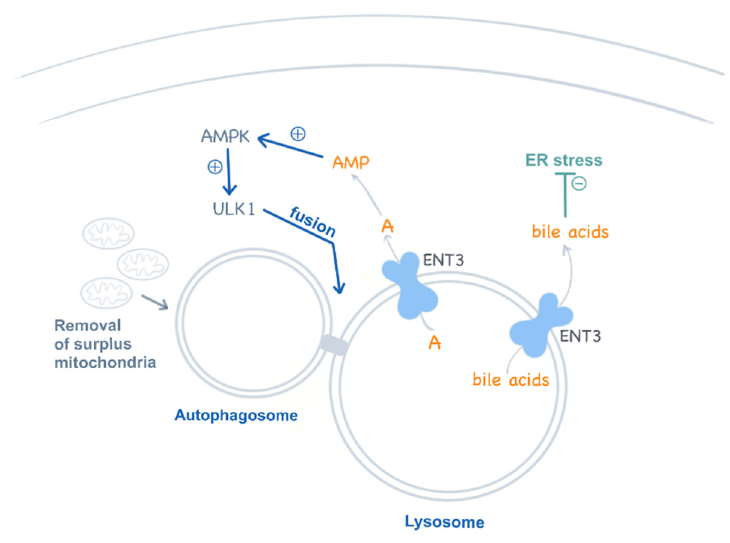
Figure 4. ENT3 functions in lysosomes. ENT3 is proposed to regulate autophagy by modulating adenosine (A) release from the lysosomes into the cytosol, which contributes to AMPK activation and the regulation of the AMPK–mTOR–ULK axis. Additionally, ENT3 has been recently proposed as a low-affinity bile acid transporter at pH 5.5, contributing to ER stress regulation.